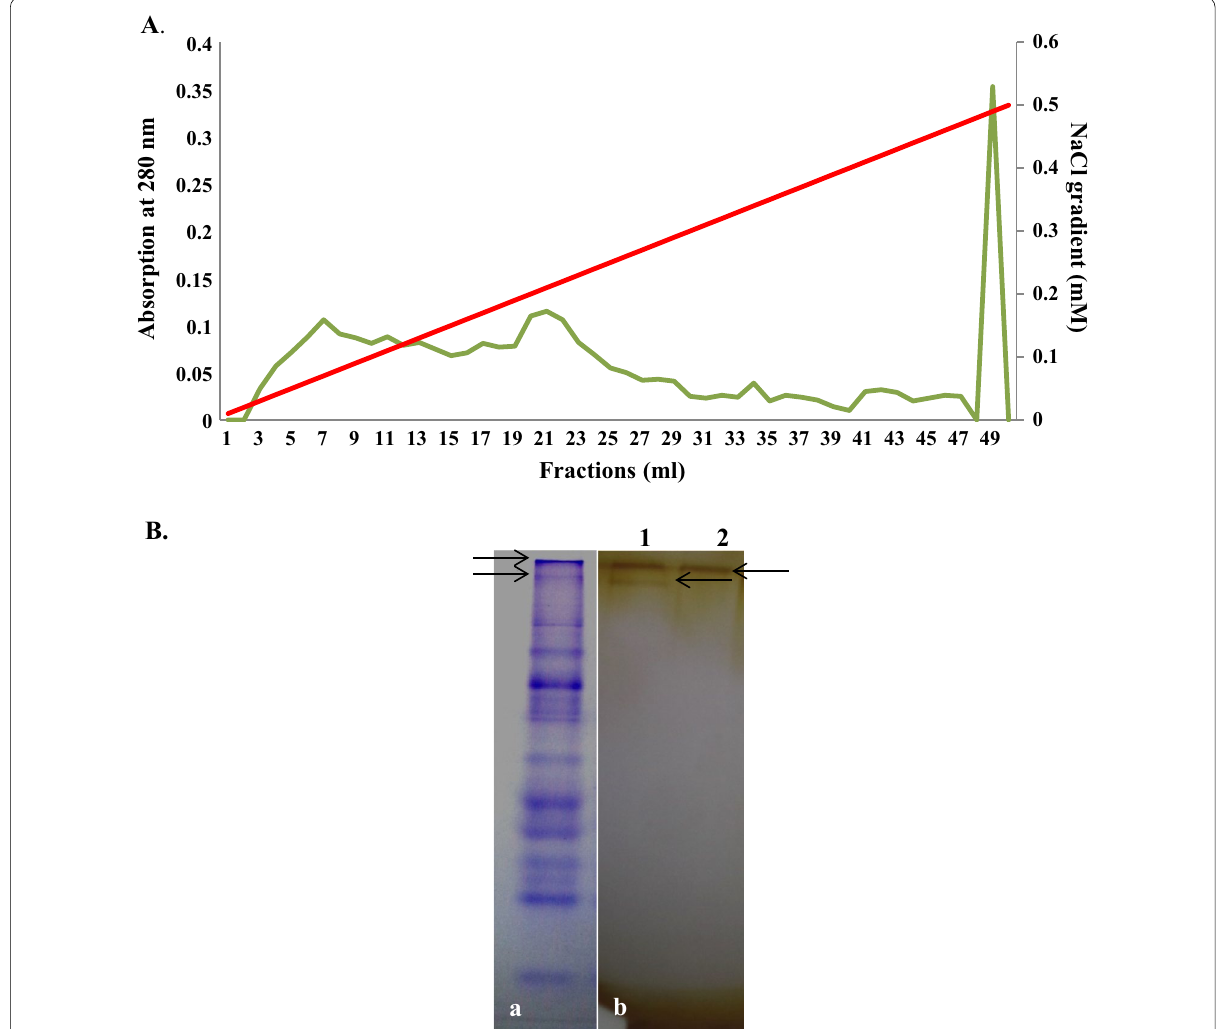
Fig. 1 Purification of venom protein from C. virgo using DEAE- Cellulose chromatography. A Chromatogram of partially purified venom protein. B Native-PAGE analysis of purified venom protein from C. virgo . A Crude venom upon staining with Coomassie brilliant blue; B partially purified venom protein upon staining with silver nitrate; Lane 1—fraction 1; and Lane 2—fraction